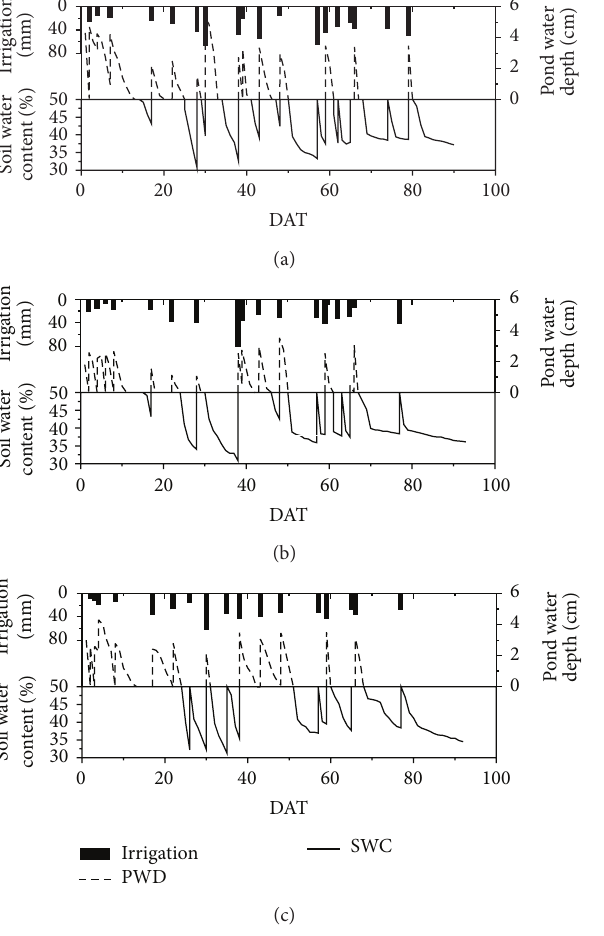
Figure 3: Typical pond water depth, soil water content, and irrigation for CWT1, CWT2, and CWT3.